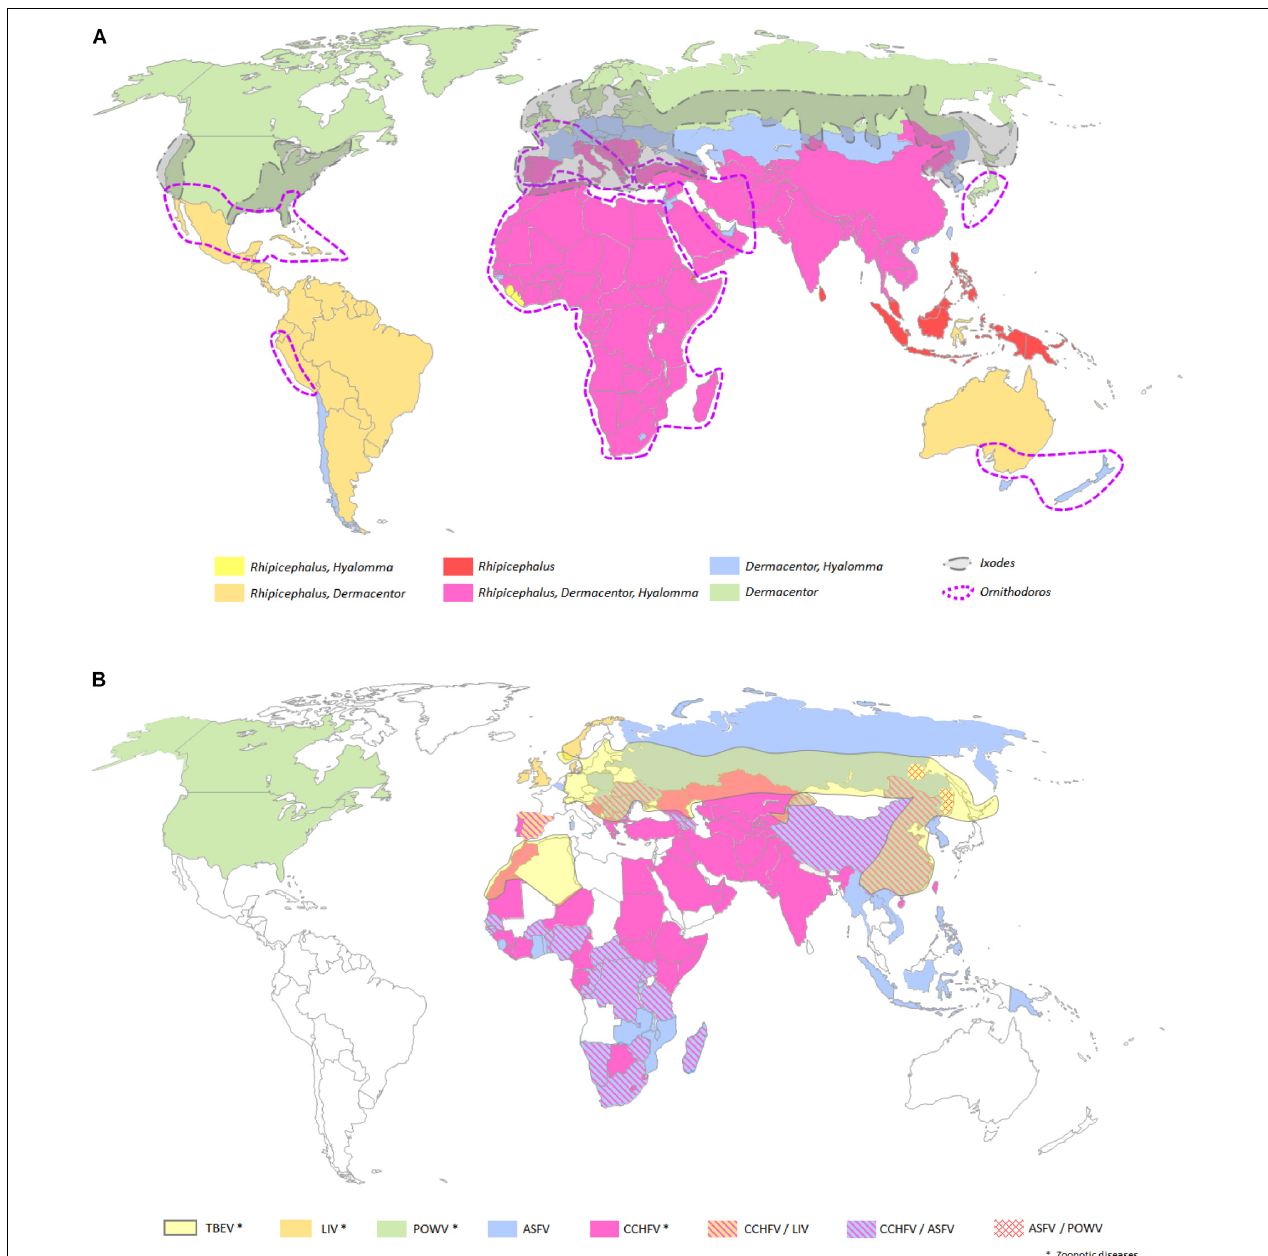
FIGURE 2 | Global distributions of tick genera of medical and veterinary importance (A) and arboviruses transmitted by ticks (B) . (A) The five tick genera reported on the map, namely, Ornithodoros , Ixodes , Rhipicephalus , Dermacentor , and Hyalomma spp., are the most prevalent ones around the world representing the principal vectors of arboviruses. (B) Map of the main arboviruses transmitted by ticks. The yellow, orange, green, blue, and pink areas represent respective presence of the tick-borne flaviviruses, namely, tick-borne encephalitis virus (TBEV), Louping ill virus (LIV), and Powasan virus (POWV); the Asfivirus, namely, African swine fever virus (ASFV); and the Orthonairovirus, namely, Crimean-Congo hemorrhagic fever virus (CCHFV) (Myers, 2015; Dupraz et al., 2016; Diuk-Wasser et al., 2016; DW Akademie, 2016; de la Fuente et al., 2017; Frant et al., 2017; Galgani et al., 2017; Bakkes et al., 2018; Lindqvist et al., 2018; Andersen et al., 2019; Burrow et al., 2019; Kemenesi and Banyai, 2019; Wang et al., 2019; Centers for Disease Control and Prevention, 2020b; Gaudreault et al., 2020; World Health Organization, 2020). The map was built using the open source map site